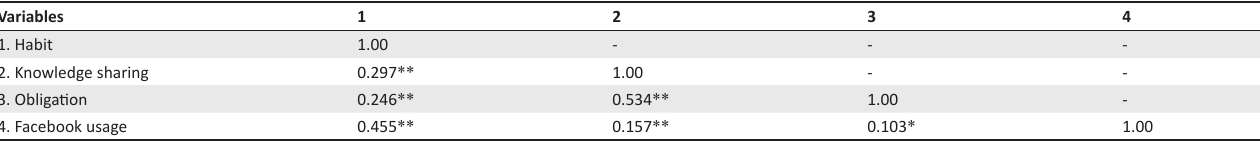
TABLE 6: Correlations. Variables